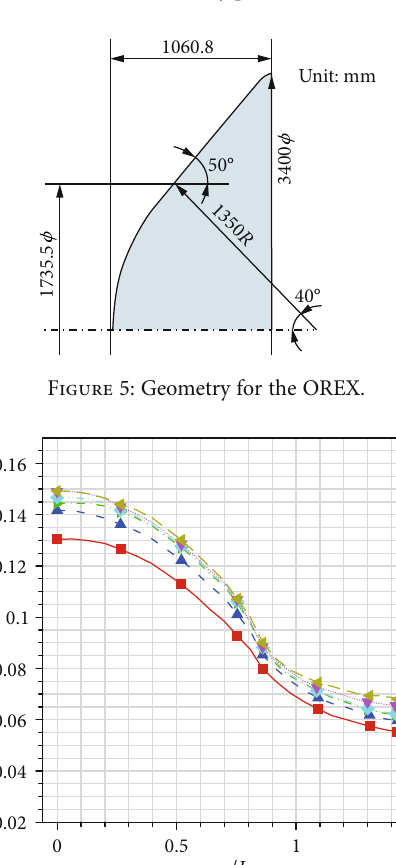
Figure 4: Laminar velocity pro fi les at x = 0 : 06m .